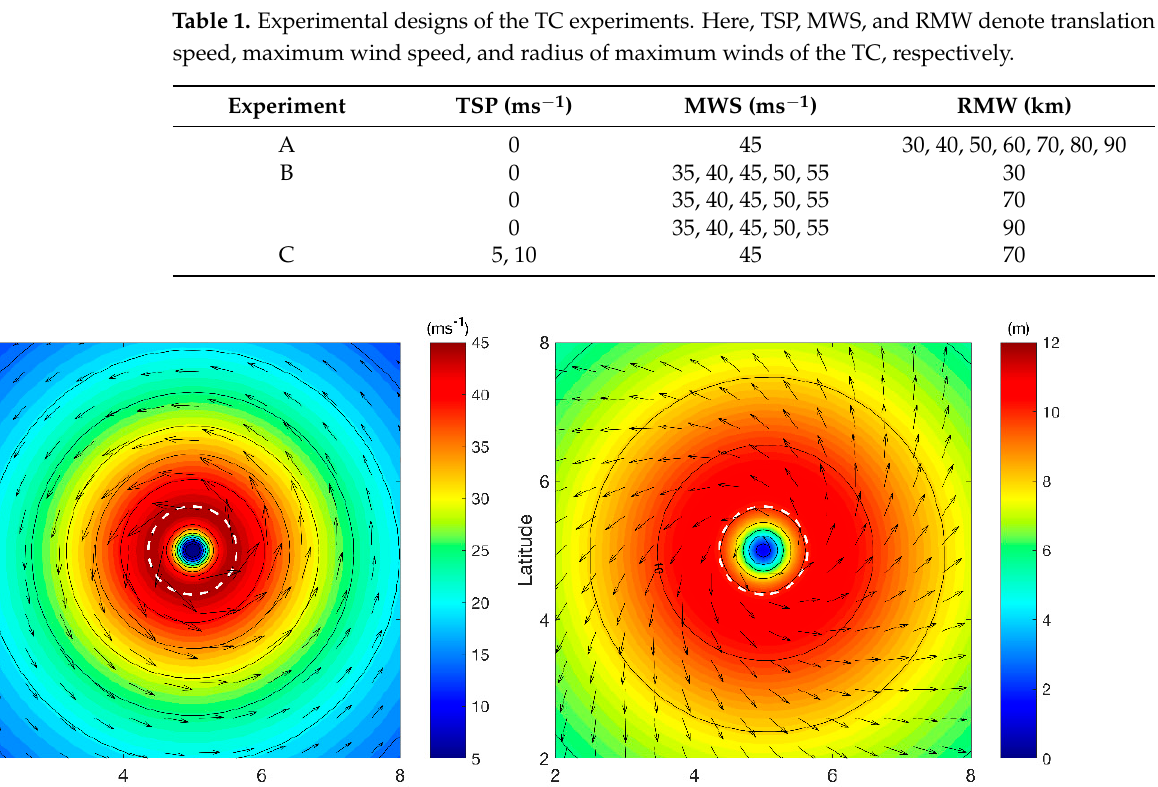
Figure 1. ( left ) Wind field in experiment A with RMW = 70 km. The arrows indicate wind speed vector, the color scales indicate wind speed magnitude (ms − 1 ), and the contours are given at every 5 ms − 1 . ( right ) Wave field under the stationary TC: the arrows indicate dominant wave direction, the color scales indicate significant wave height (m), and the contours are given at every 2 m. The dashed white line in both figures give the location of RMW.